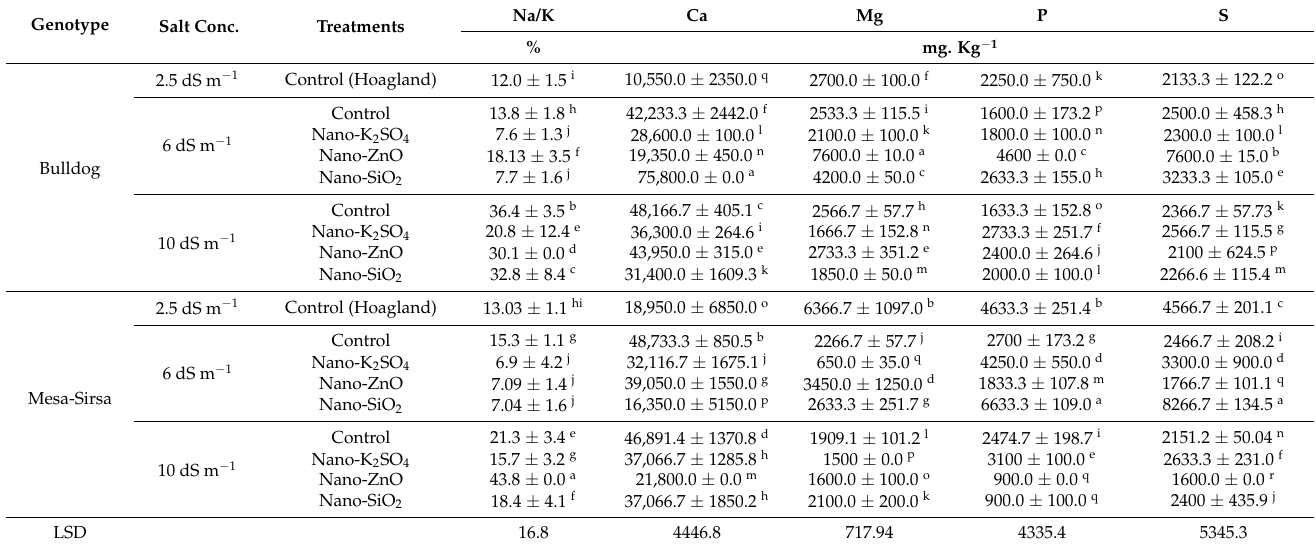
Table 4. Macro-elements in plant tissue of two alfalfa genotypes as affected by three salt levels (0 and 6 dS m − 1 Electrical Conductivity) and different nano-fertilizers (K 2 SO 4 , ZnO, and SiO 2